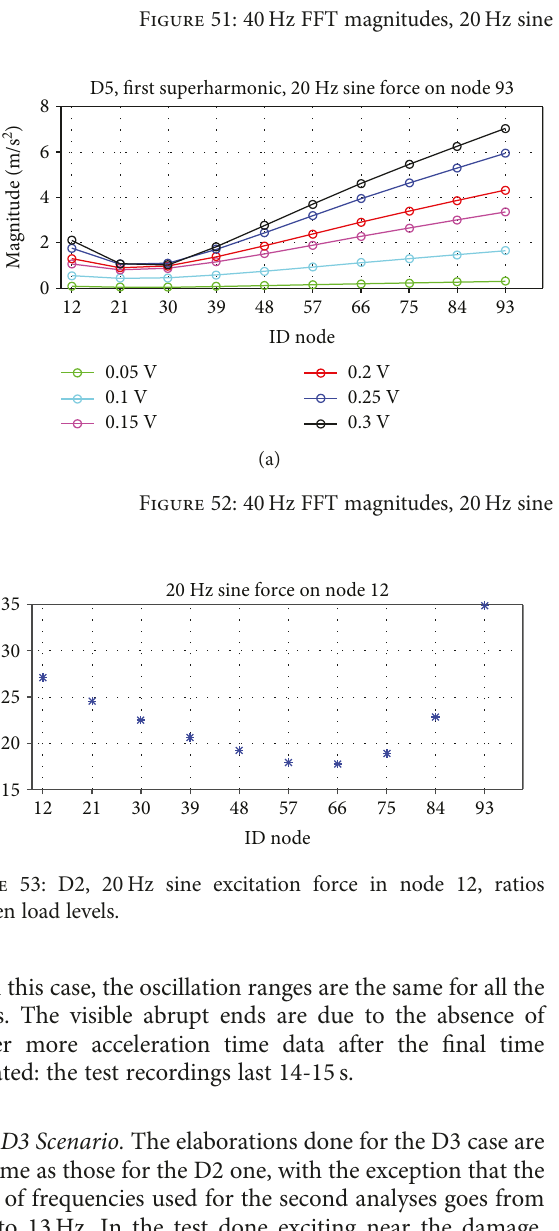
Figure 54: Instrumented hammer used for decay tests.